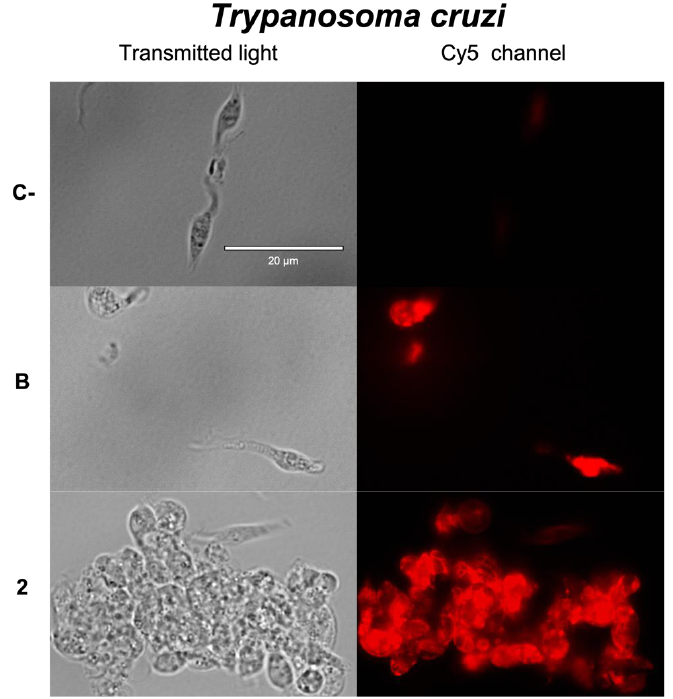
Figure 6. Detection of reactive oxygen species by CellROX ® Deep Red Reagent. The images represent promastigotes of L. amazonensis after 24 h of incubation with the IC 90 of 4β -hydroxyarbusculin A ( 11 ) and anhydroartemorin ( 2 ), promastigotes of L. donovani after 24 h of incubation with the IC 90 of cis,trans -costunolide-14-acetate ( 3 ) and epimastigotes of T. cruzi after 24 h of incubation with the IC 90 of anhydroartemorin ( 2 ). Parasites without any treatment were used as negative control ( C- ), and miltefosine ( M ) and benznidazole ( B ) were used as reference treatments against Leishmania spp. and Trypanosoma cruzi , respectively. Pictures were captured by using an EVOS FL Cell Imaging System (100×). Scale bar: 20 μm.